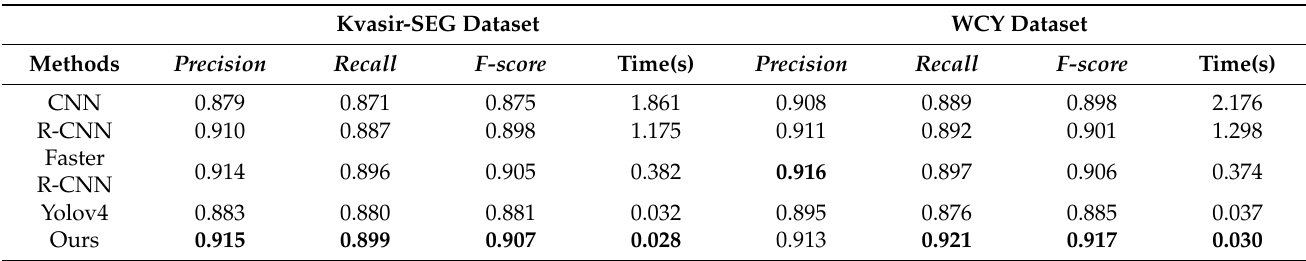
Table 1. Performance of polyp detection between different algorithms. In the table, we bold the optimal results obtained by each